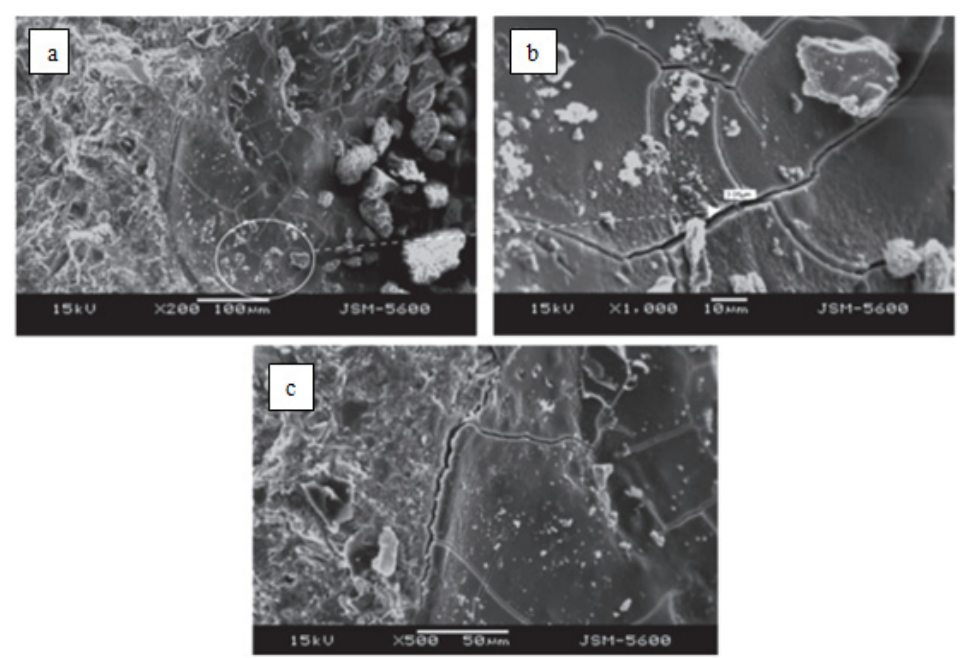
Figure 3. SEM images of mortar bar samples of granite: ( a,c ) typical expansion cracks produced in gel, ( b ) close view of same cracks [34].